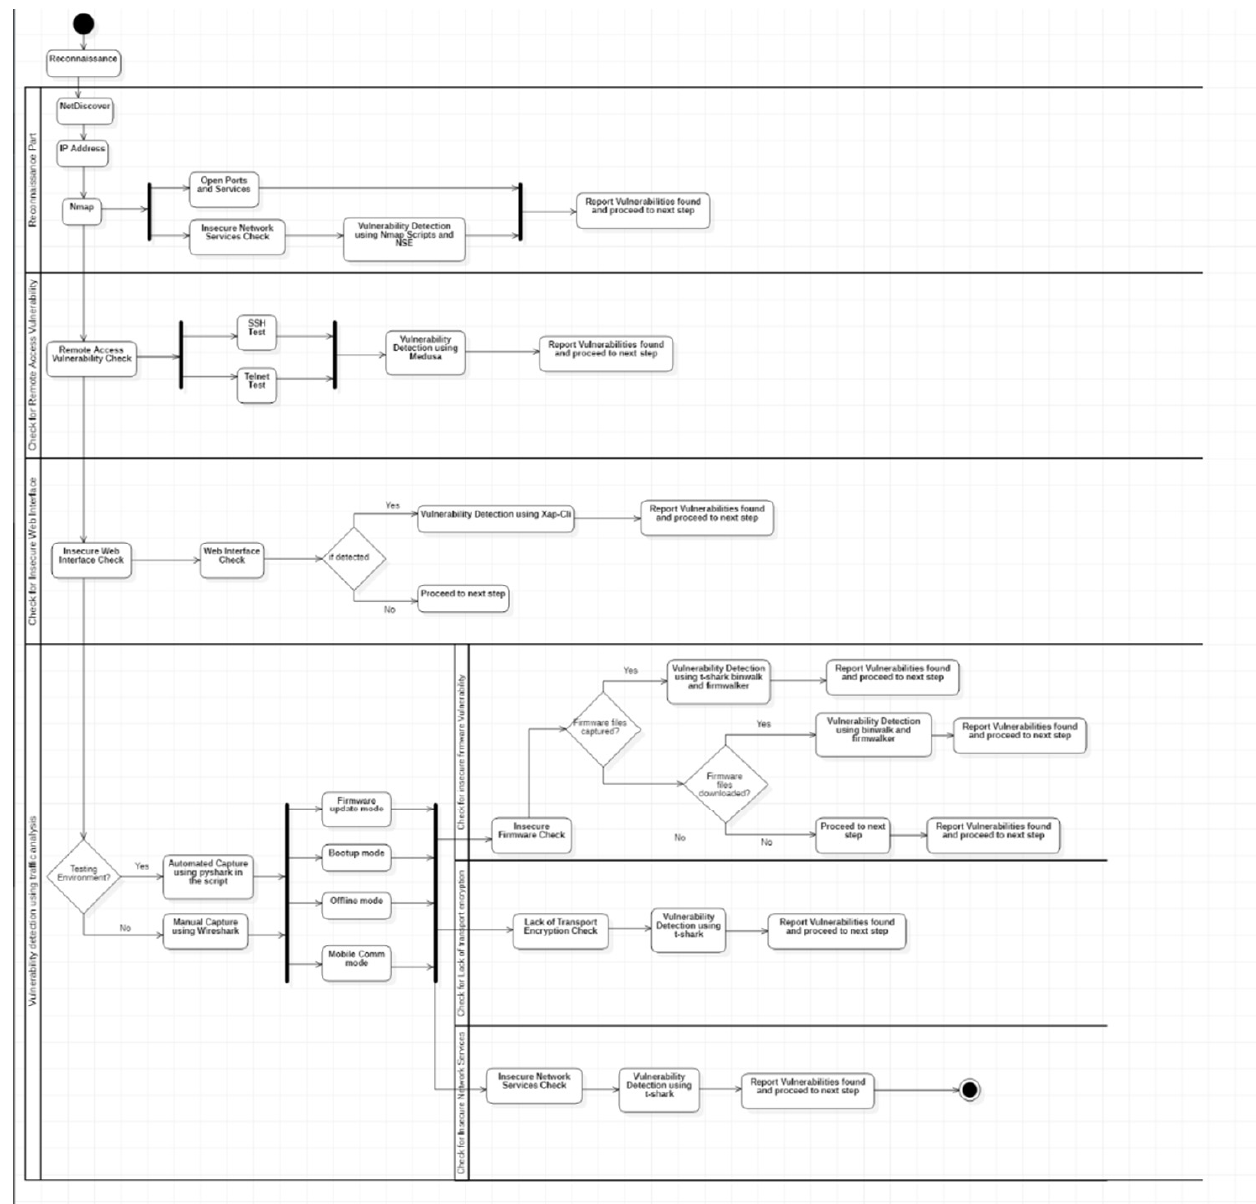
Figure 3. UML activity diagram for the algorithm followed by the framework.